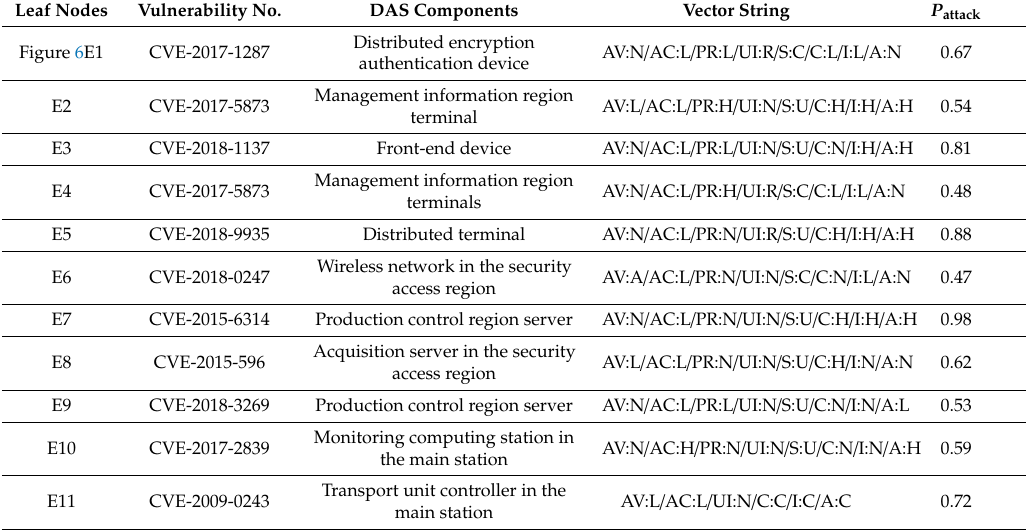
Table 3. Results on the attack probability of the DAS nodes.